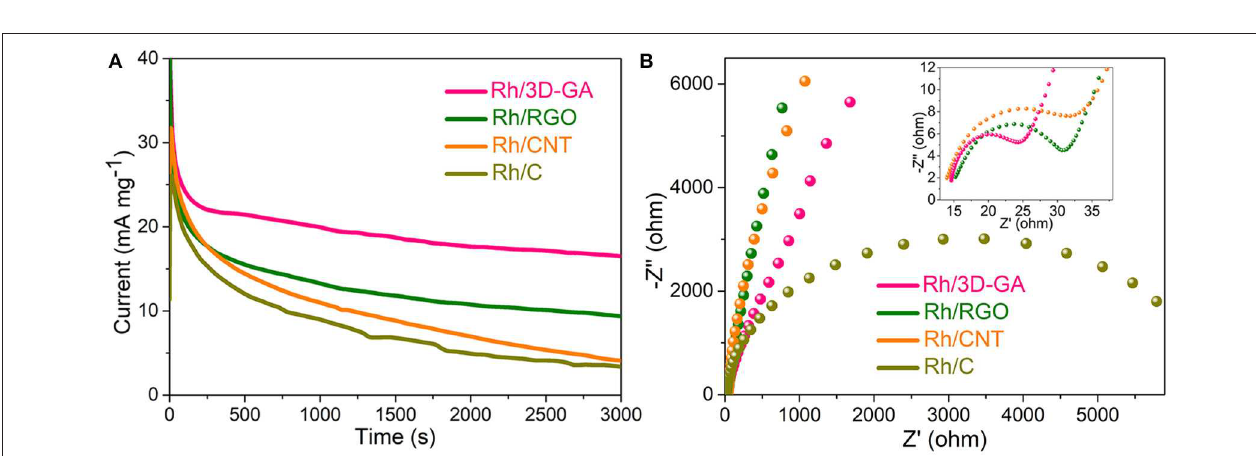
FIGURE 4 | (A) Chronoamperometric curves of the Rh/3D-GA, Rh/RGO, Rh/CNT, and Rh/C electrodes recorded in 1M KOH with 1M CH 3 OH solution at − 0.5V. (B) AC impedance spectra of the above four catalysts in 1M KOH with 1M CH 3 OH solution tested at open circuit potentials with an amplitude of 10mV.